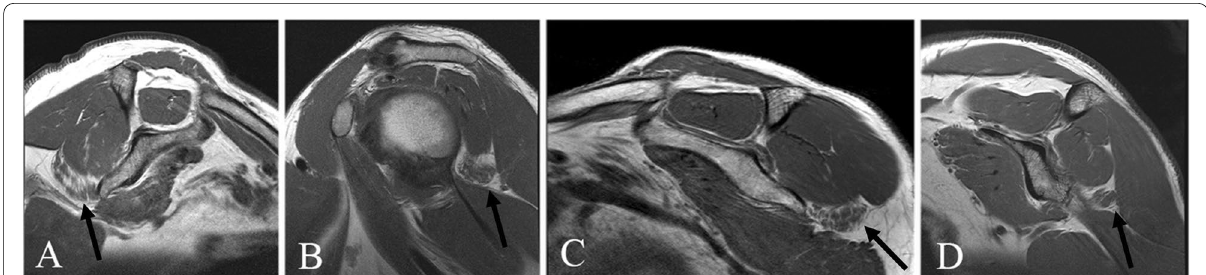
Fig. 1 Sagittal T1‑weighted MRI demonstrating fatty infiltration of the teres minor muscle in 4